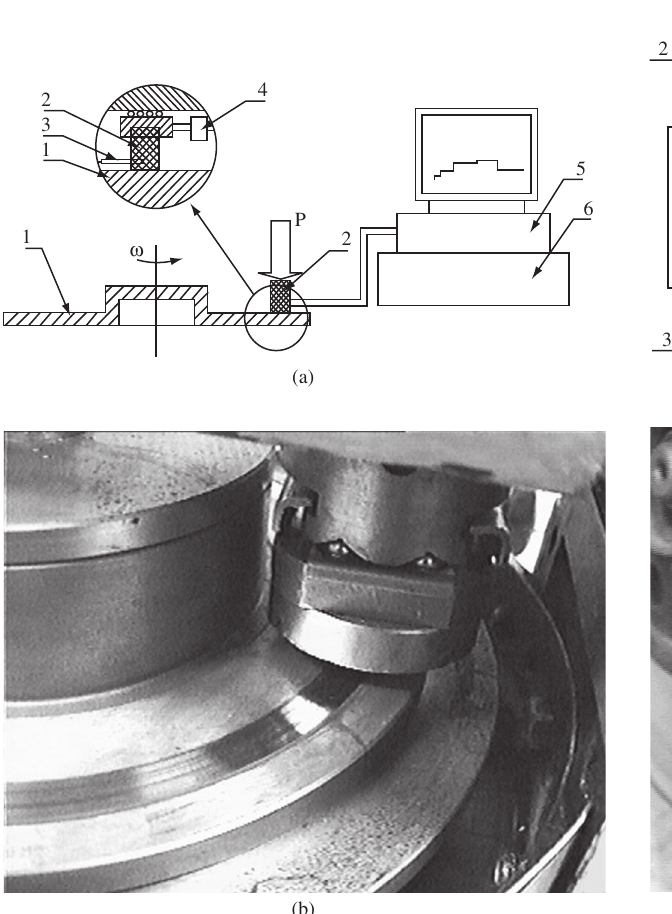
Figure 2. In-field measurement system: diagram a) 1-PC computer, 2-Spider 8 data acquisition device, 3-voltage inverter, 4-brake disc, 5-brake pad, 6-pres- sure sensor, 7-thermocouple (J), 8-speed sensor; and b) view of brake disc and caliper with thermocouple.